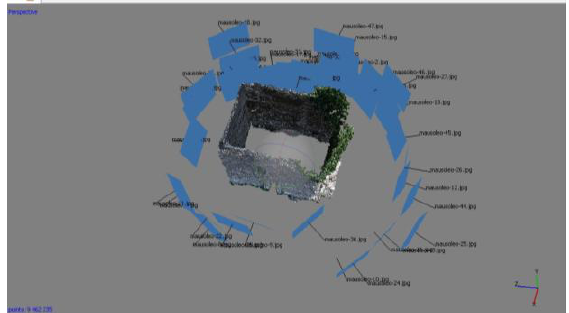
Figure 2. Mausoleum: the camera calibration and